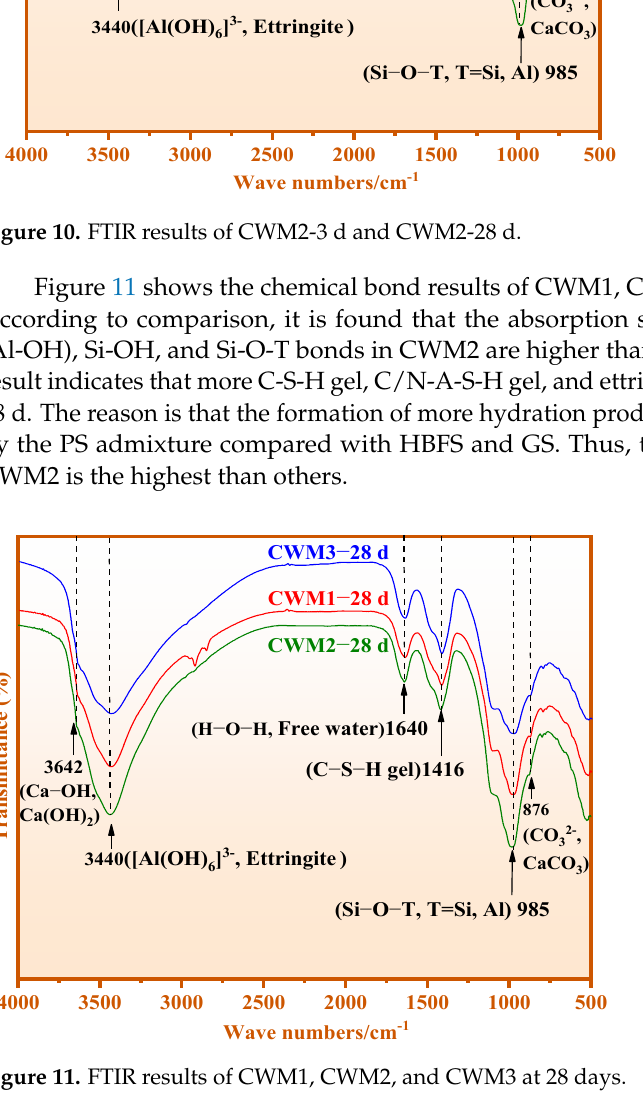
Figure 11. FTIR results of CWM1, CWM2, and CWM3 at 28 days.